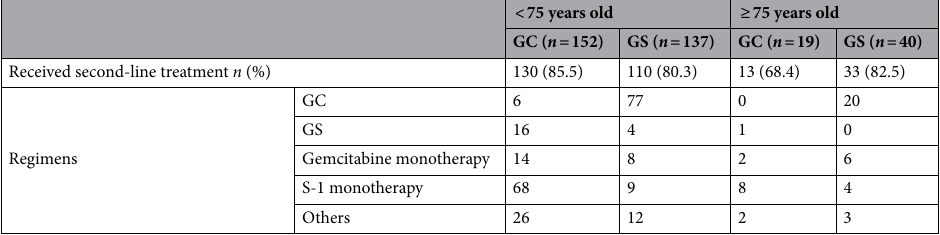
Table 4. Details of second-line treatment in GC and GS. GC, gemcitabine plus cisplatin; GS, gemcitabine plus